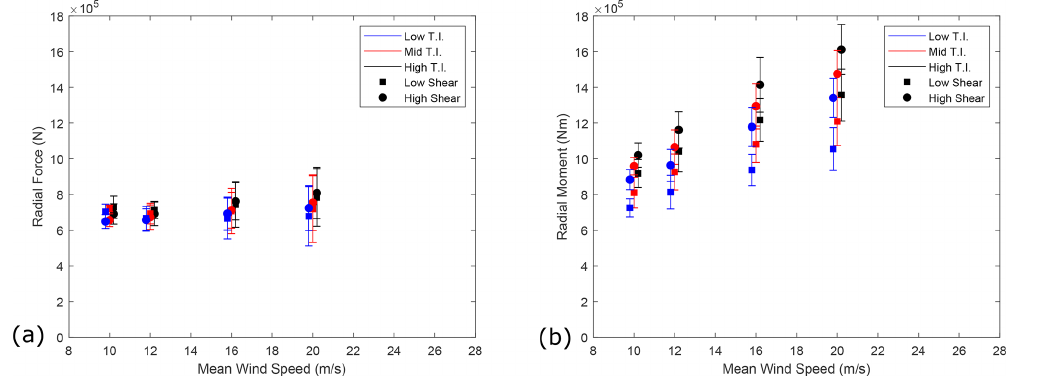
Figure 19. (a) Peak radial resultant force magnitudes from the analytical DTRB model. Mean and standard deviations within each CPLS are plotted, staggered about mean wind speeds for clarity. (b) Peak resultant moment magnitudes from the analytical DTRB model. Mean and standard deviations within each CPLS are plotted, staggered about mean wind speeds for